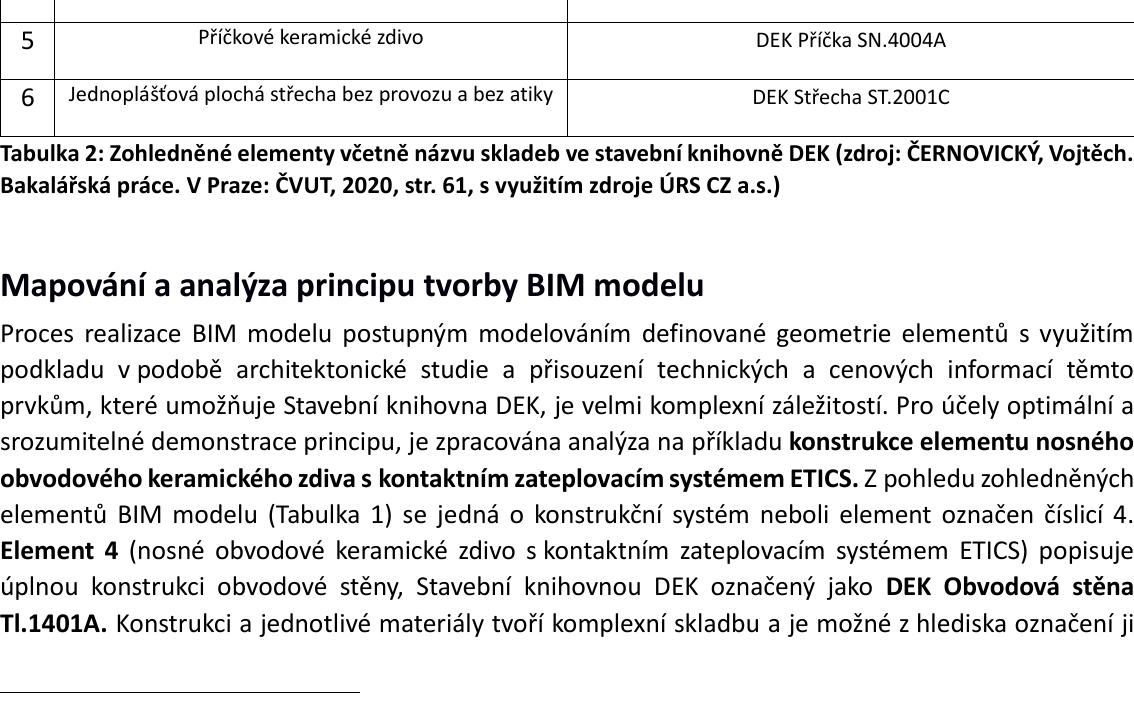
Mapování a analýza principu tvorby BIM